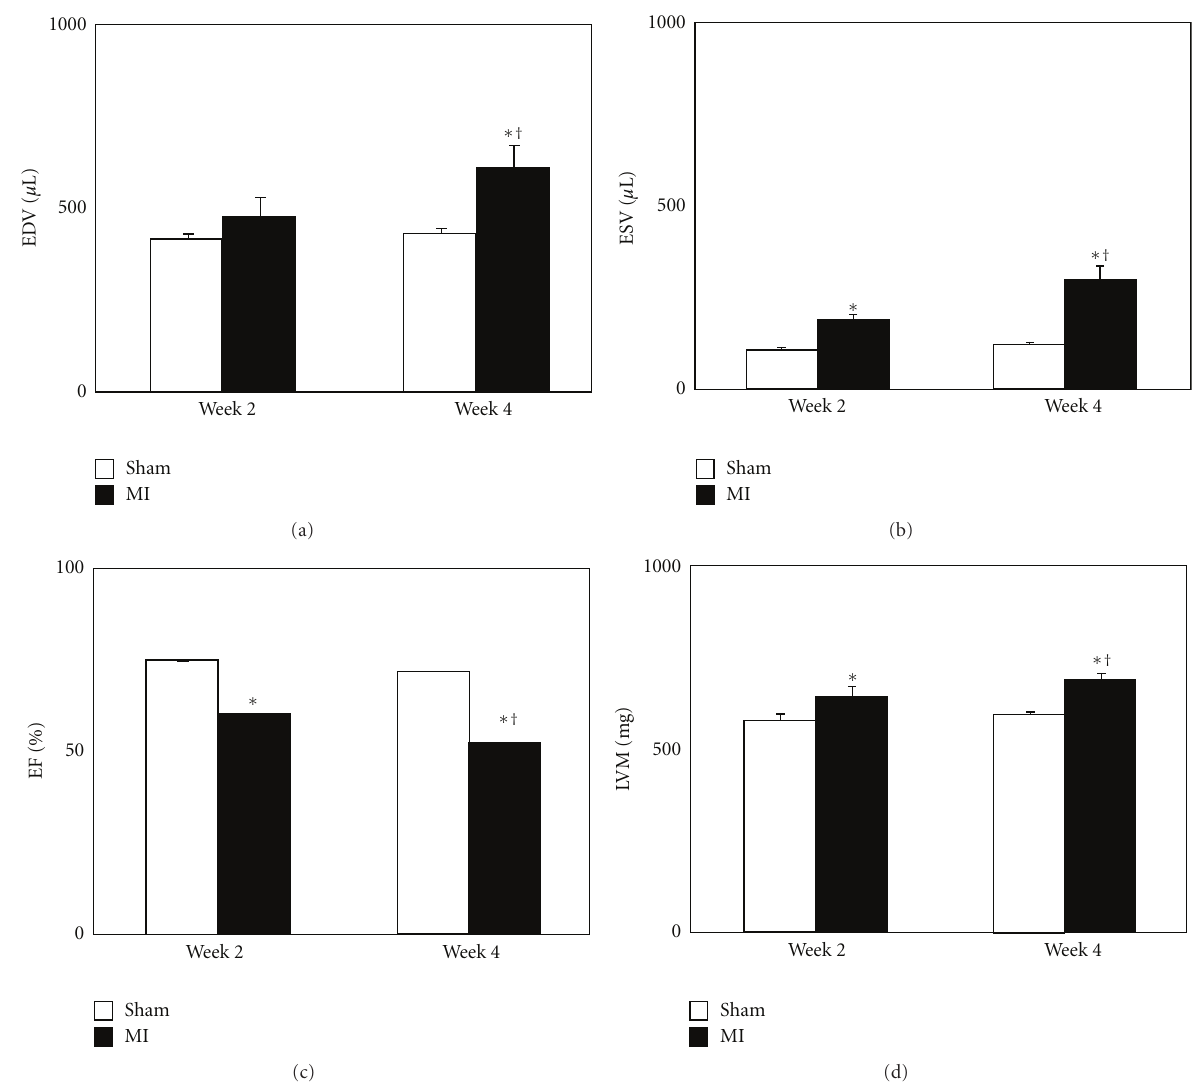
Figure 5: Average LV functional parameters and LVM determined by MRI. In the MI group, EDV (a) and ESV (b) were significantly higher at 4 weeks. ESV was also higher at 2 weeks compared to sham rats. EF (c) was significantly lower at both 2 and 4 weeks. LVM (d) was significantly higher at 2 weeks and 4 weeks in MI rats indicating hypertrophy. ∗ P < 0 . 05 versus week 2 sham, † P < 0 . 05 versus week 4